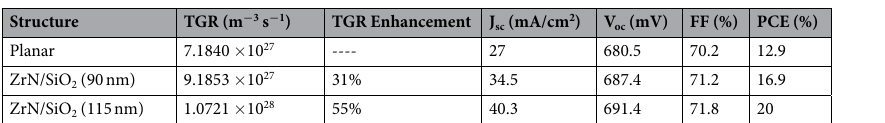
Table 3. The optical and electrical parameters of the ZrN/SiO 2 -decorated